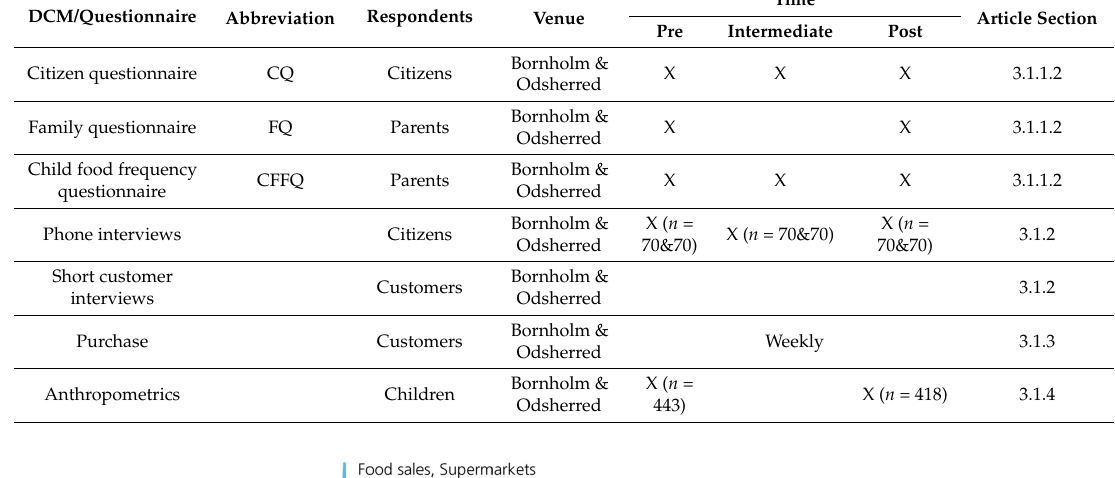
Table 1. Overview of formative and summative data collecting methods.